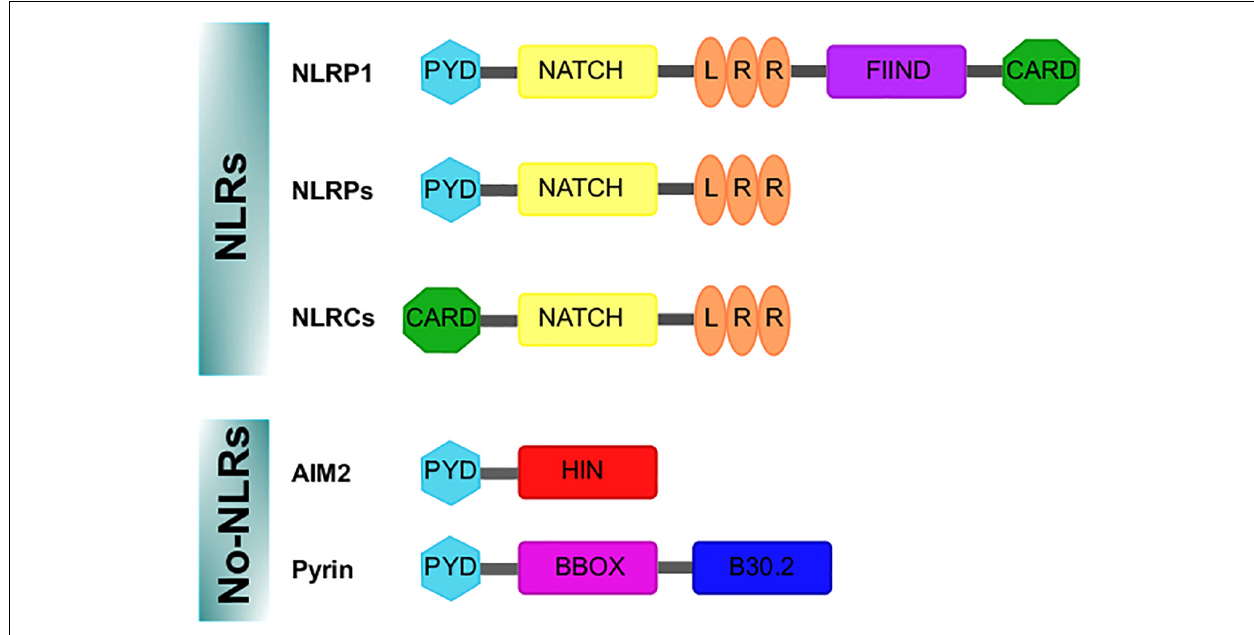
FIGURE 1 | Domains structure of the inflammasomes sensor proteins. Nod like receptor (NLRs) proteins have a nucleotide-binding and oligomerization domain (NACHT/NBD), a leucine-rich repeat (LRR) motifs, typically located in the center and carboxy terminus of the NLR proteins, respectively. The NACHT motif is usually flanked by an additional amino-terminal domain, either a caspase recruitment domain (CARD) or a pyrin domain (PYD). For NLRP1, a FIIND and CARD domain are in the C-terminal position after the LRR domain. In addition, the absent in melanoma 2 (AIM2)-like receptor and Pyrin are no-NLR inflammasome sensors. AIM2 is characterized by an amino-terminal PYD domain and one or two DNA-binding HIN domains. Pyrin, features a PYD domain, two B-boxes, and a C-terminal B30.2